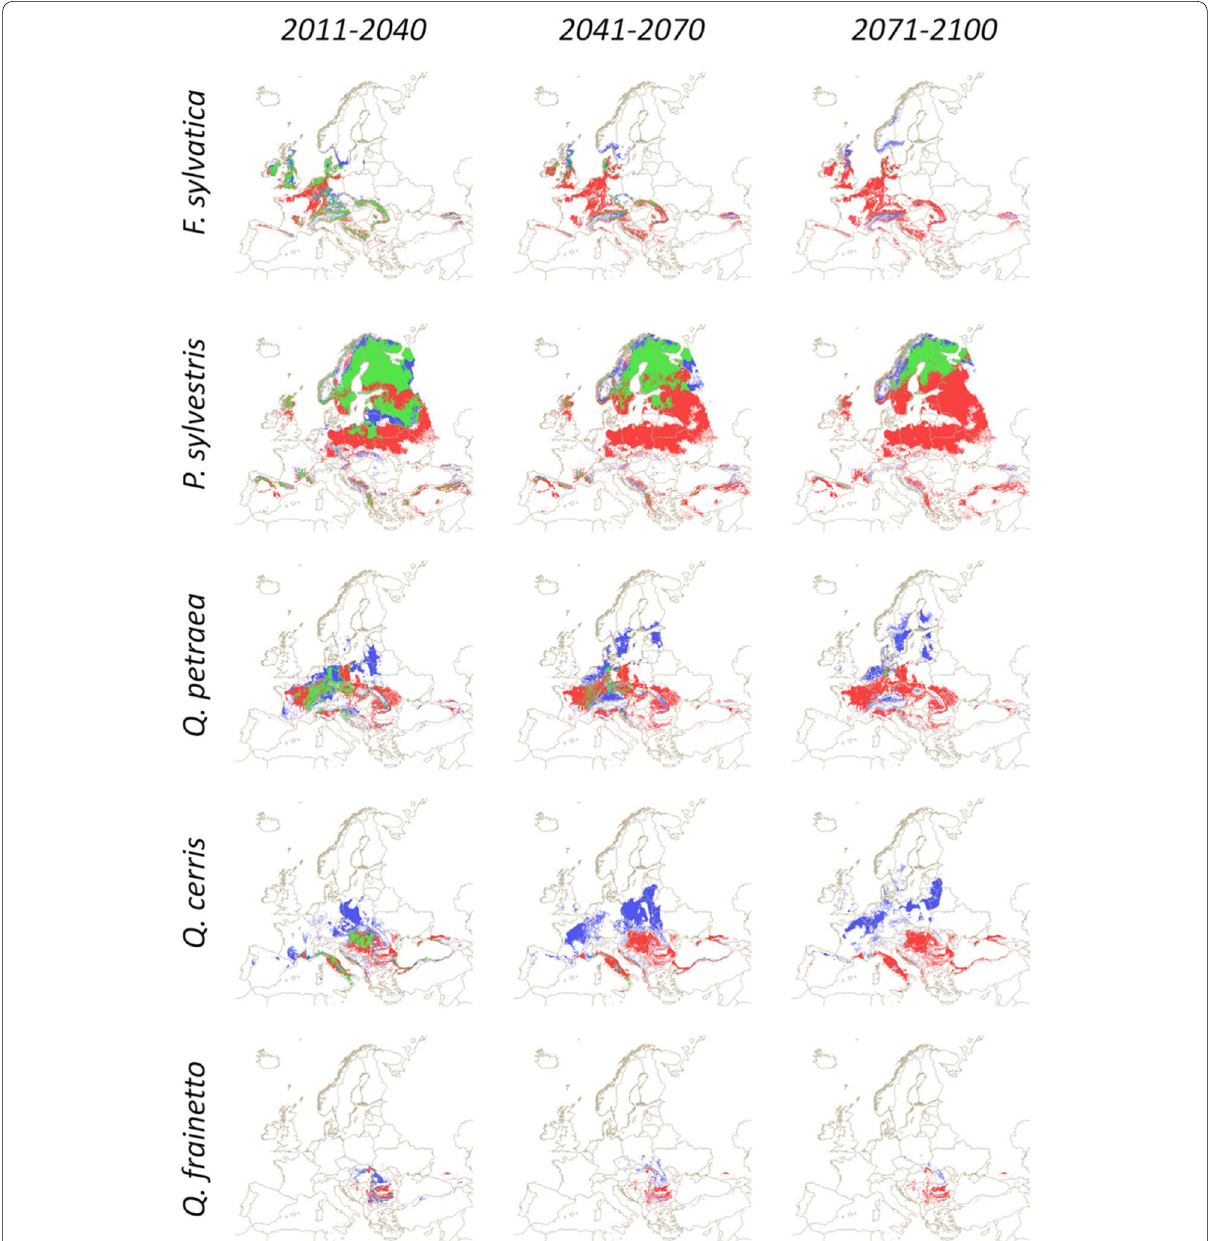
Fig. 4 Projected potential climate envelope shift of some selected tree species under the emission scenario RCP 8.5. Green areas indicate identical areas under current and future predictions, blue indicates areas that are potentially occupied, and red indicates areas that are potentially